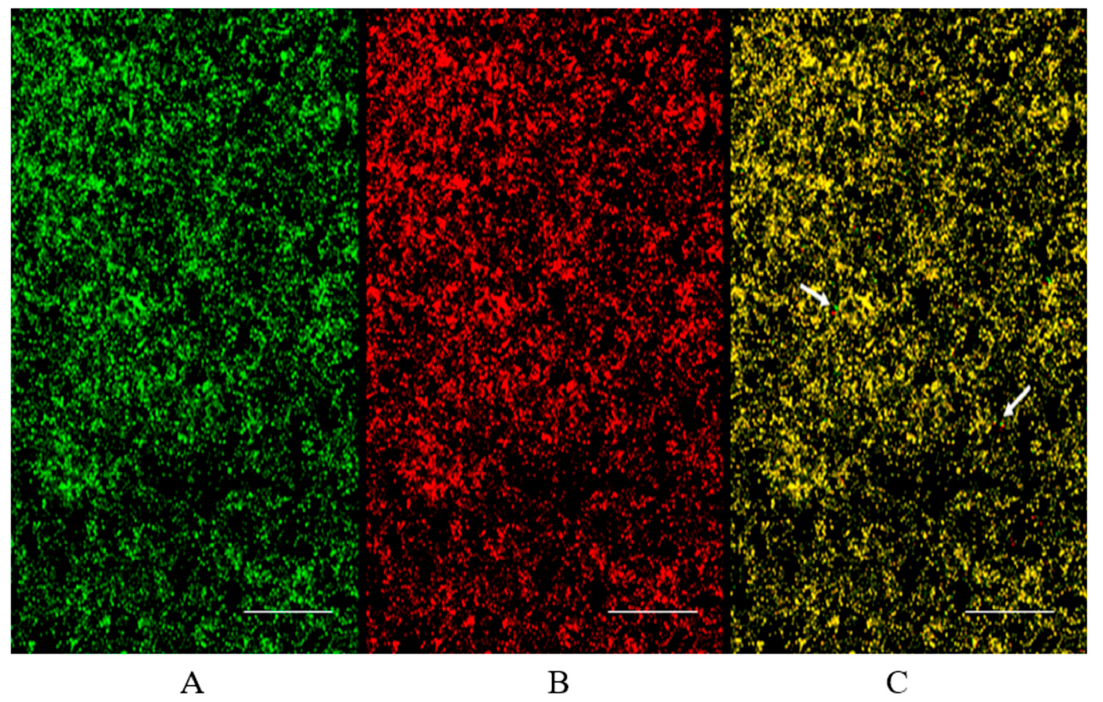
Figure 3. Visualization at CSLM of persister cells in C. auris biofilm treated with 200 µ g mL − 1 of caspofungin and stained with SYTO9/PI: ( A ) observation at SYTO (9 λ max : all cells in the biofilm appear green; ( B ) observation at PI λ max : cells in the biofilm are not alive and appear red; ( C ) merge: very few cells appear bright green (persisters). Arrows indicate the few persisters. Bars correspond to 50 µ m.